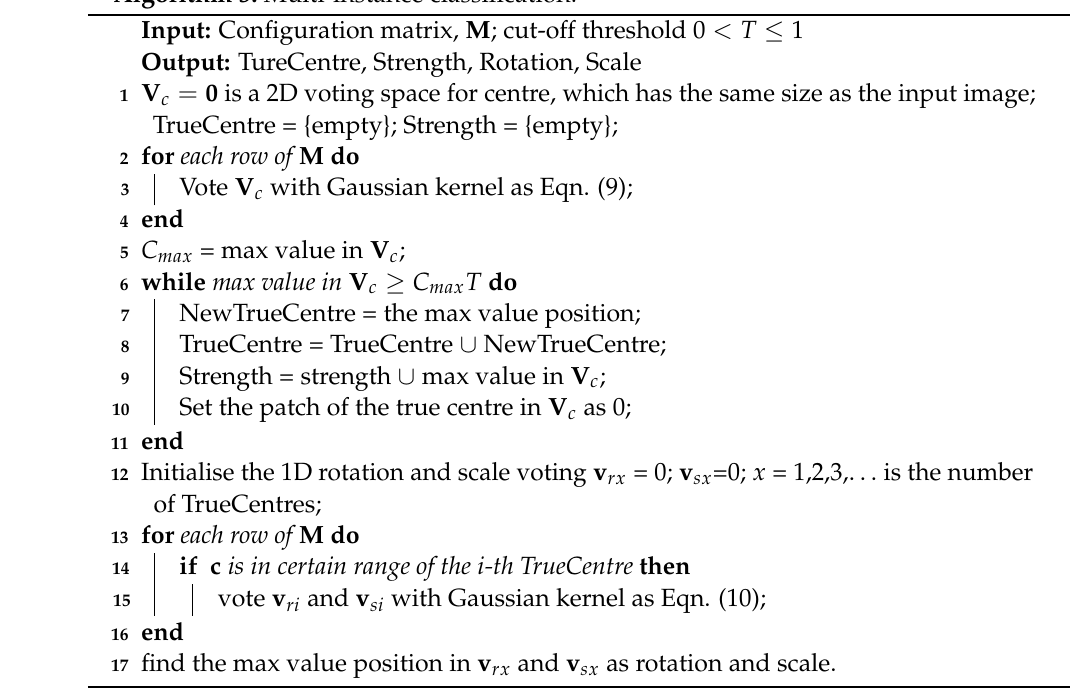
Algorithm 3: Multi-instance